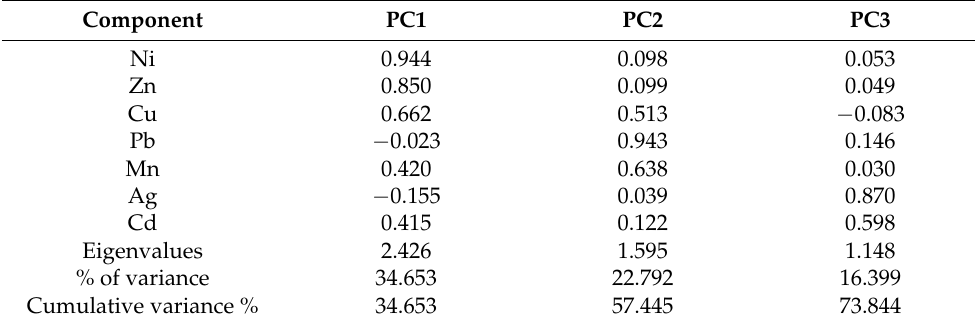
Table 3. Principal component factor loading of heavy metals in the Han River